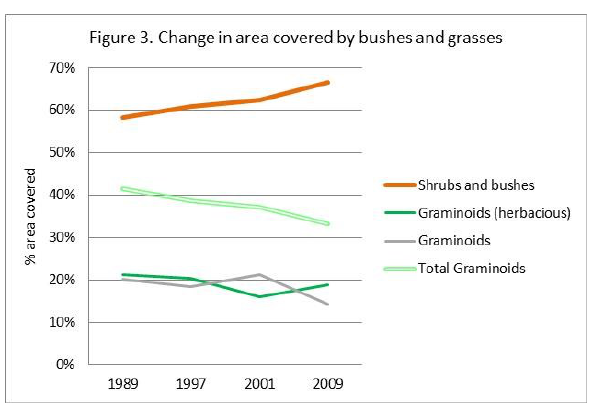
Figure 3. Change in area covered by bushes and grasses